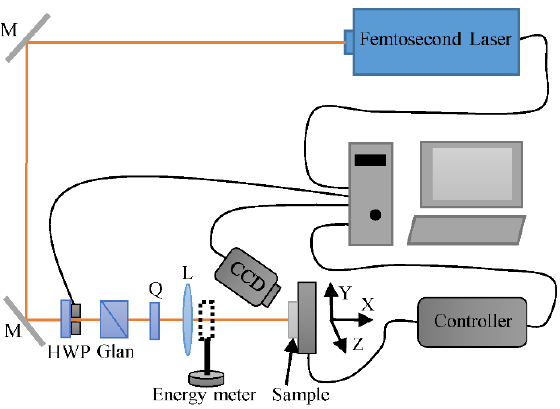
Figure 2. Experimental setup of femtosecond laser damage to optical thin films (M is the 800 nm mirror; HWP is the half-wave plate; Glan is the Glan-laser polarizer; Q is the quarter-wave plate; L is focusing lens).